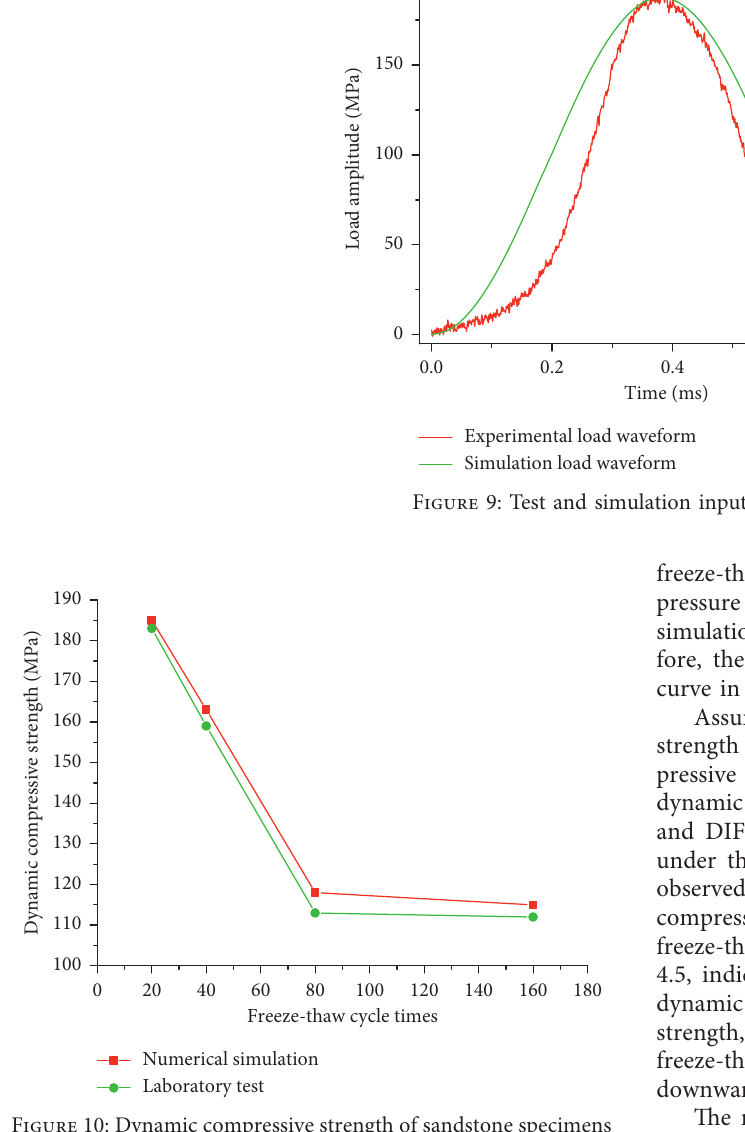
Figure 10: Dynamic compressive strength of sandstone specimens under indoor and numerical SHPB